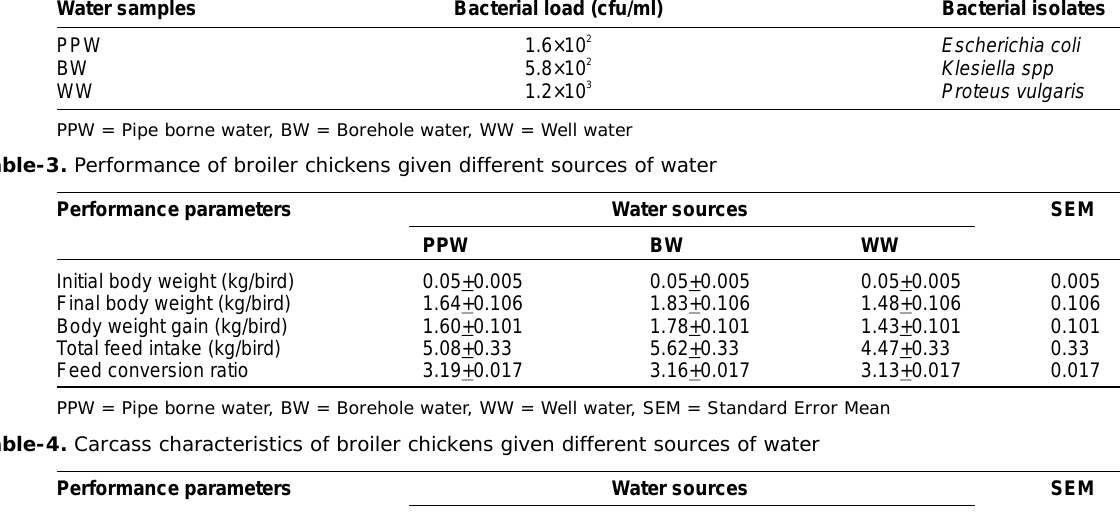
Table-2. Bacterial analysis of experimental waters Water samples